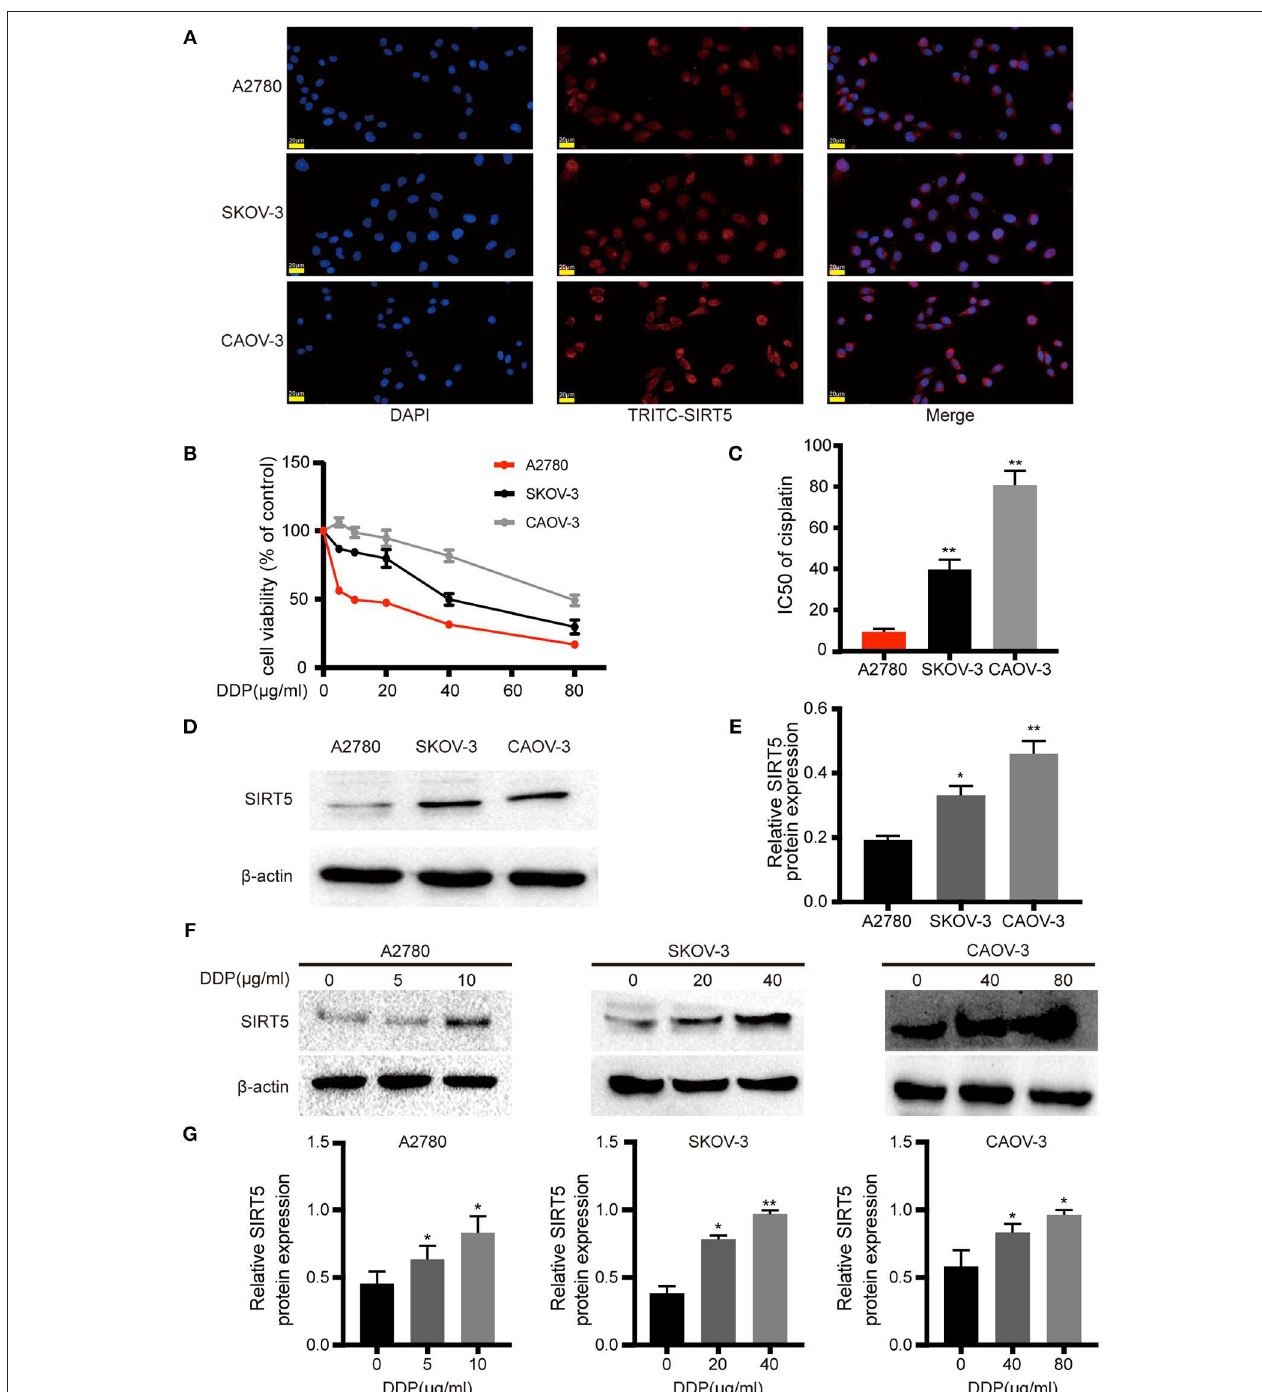
FIGURE 2 | SIRT5 expression is involved in cisplatin-resistant of ovarian cancer cells. (A) SIRT5 expression in three ovarian cancer cell lines analyzed by immunofluorescence staining using TRITC-labeled antibodies; nuclei were stained with DAPI. (B) Differences in cisplatin sensitivity of three ovarian cancer cell lines assessed by CCK-8 assay. (C) Calculated IC50 values after cells were exposed to the indicated dose of cisplatin for 48h. (D) SIRT5 protein levels in three ovarian cancer cell lines assessed by western blot and (E) relative protein expression was quantified by relative gray value of bands with ImageJ software. (F,G) SIRT5 protein levels were upregulated during exposed to indicated dose of cisplatin in three ovarian cancer cell lines for 48h. DDP, cisplatin. Data are presented as the mean ± SD of three independent experiments. Scale bar = 20 µ m, * P < 0.05, ** P < 0.01, compared with A2780 or control cells.